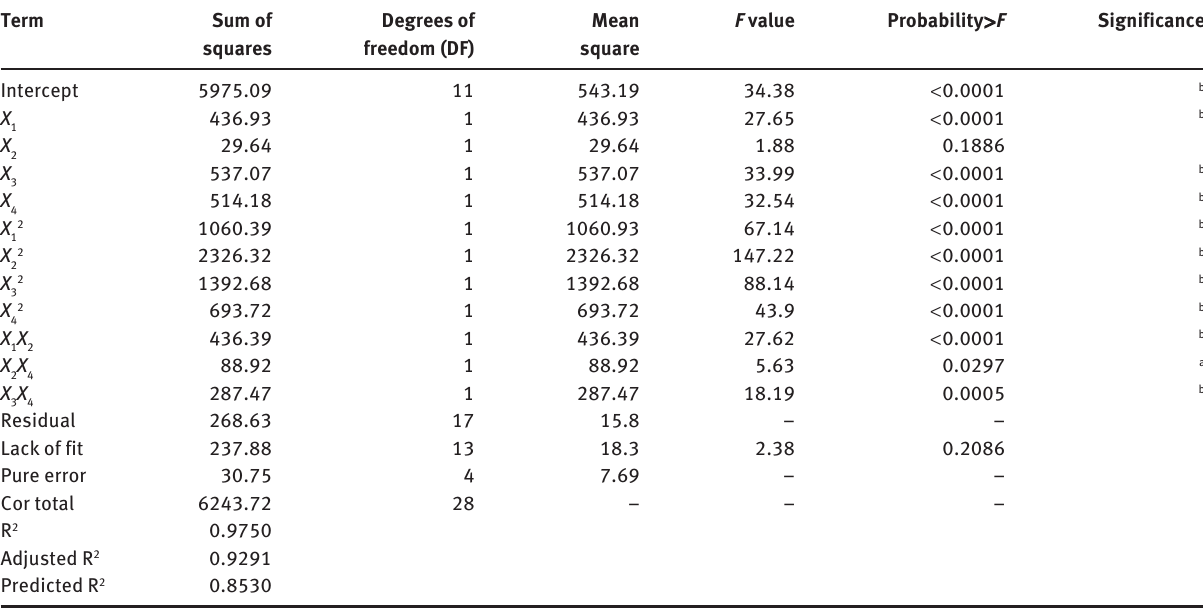
Table 3 Regression coefficient of predicted quadratic polynomial model and fit statistics for Y . Term Sum of